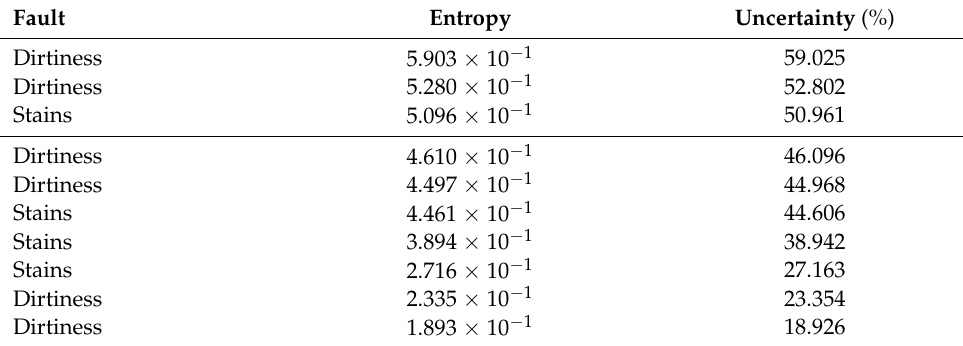
Table 3. A final report showcasing inference results from the Steel Plates Faults dataset. A threshold set at 50% implies the human expert has to cross-check only the first three